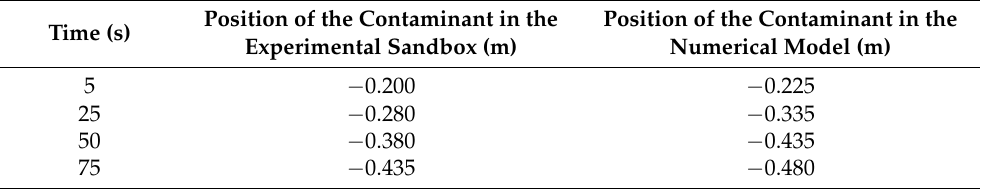
Table 3. Values of the position of the contaminant migration in the sandbox experiment, and in the numerical model output, for different times. Position of the Contaminant in the Position of the Contaminant in the Time (s) Experimental Sandbox (m) Numerical Model (m) 5 − 0.200 − 0.225 25 − 0.280 − 0.335 50 − 0.380 − 0.435 75 − 0.435 −